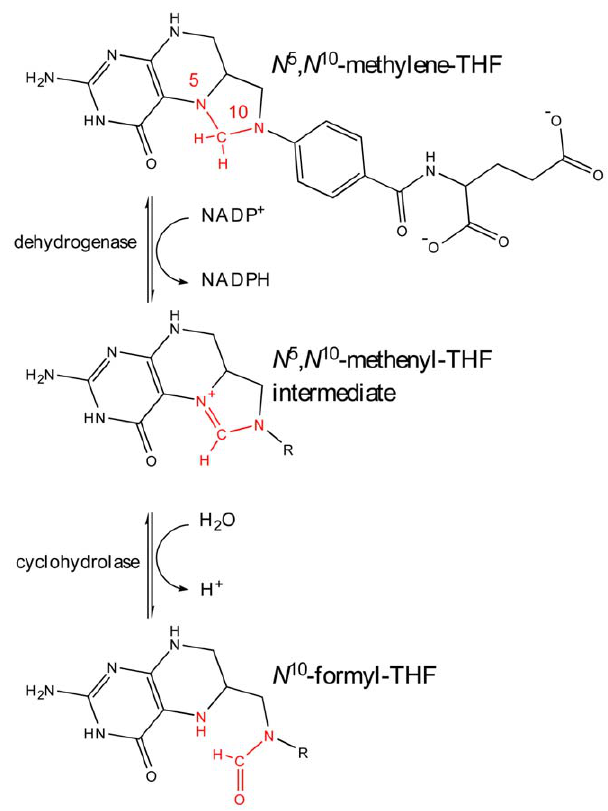
Figure 1. The reaction catalyzed by FolD. N 5 , N 10 -methylene-THF is converted to N 5 , N 10 -methenyl-THF and subsequently N 10 -formyl-THF in a two-step reaction, initially in an NADP + or NAD + dependant oxidization to by N 5 , N 10 -methylenetetrahydrofolate dehydrogenase [DH, EC:1.5.1.5] and subsequent hydrolysis by N 5 , N 10 -methenyltetrahy- drofolate cyclohydrolase [CH, EC:3.5.4.9]. [CH, EC:3.5.4.9] (Figure 1). The gene encoding this cytosolic enzyme, folD , has been shown by knock-out studies to be essential in the Gram-positive Bacillus subtilis , as well as the Gram-negative Escherichia coli , Francisella novicida , Acinetobacter baylyi , and in P. aeruginosa itself [15–19].